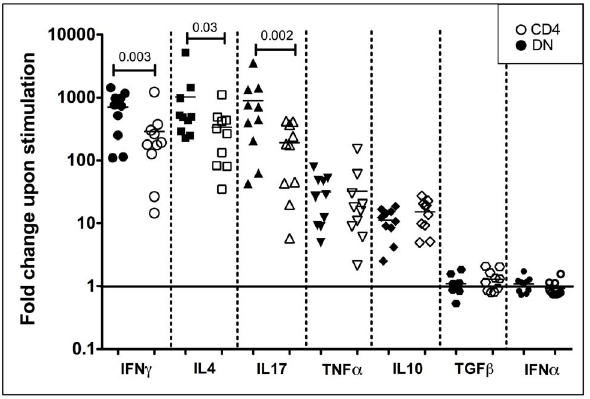
Figure 3. Quantitative real time PCR analysis of TCR stimulated DN and CD4 T cells from uninfected mangabeys. Purified DN (filled symbols) and CD4 (open symbols) T cells isolated from ten uninfected magabeys were stimulated with anti-CD3/anti-CD28. Upon stimulation, DN T cells upregulate IFN c , IL4 and IL17 mRNA to the greatest extent with higher expression of these genes (paired analysis) in DN compared to CD4 T cells. TNF a and IL10 mRNA were also upregulated by both DN and CD4 T cells. TGF b and IFN a expression was not altered following TCR stimulation in either DN or CD4 T cells. Log scale fold change is shown on the Y-axis with no change in mRNA expression due to stimulation indicated by a baseline (1 fold). Symbols represent IFN c (large circle), IL4 (square), IL17 (triangle), TNF a (inverted triangle), IL10 (diamond), TGF b (hexagon) and IFN a (small circle).